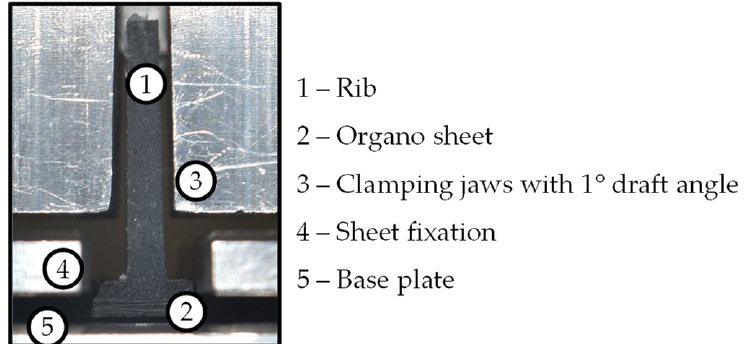
Figure 2. Cross-tension test setup with rib type B.